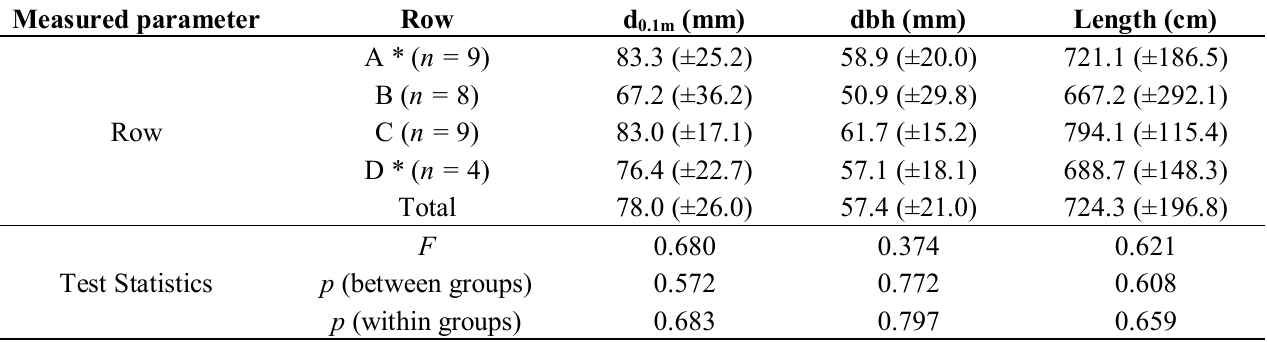
Table 2. Mean d , diameter at breast height (dbh) and length values (±SD) by row and 0.1m test statistics (df =